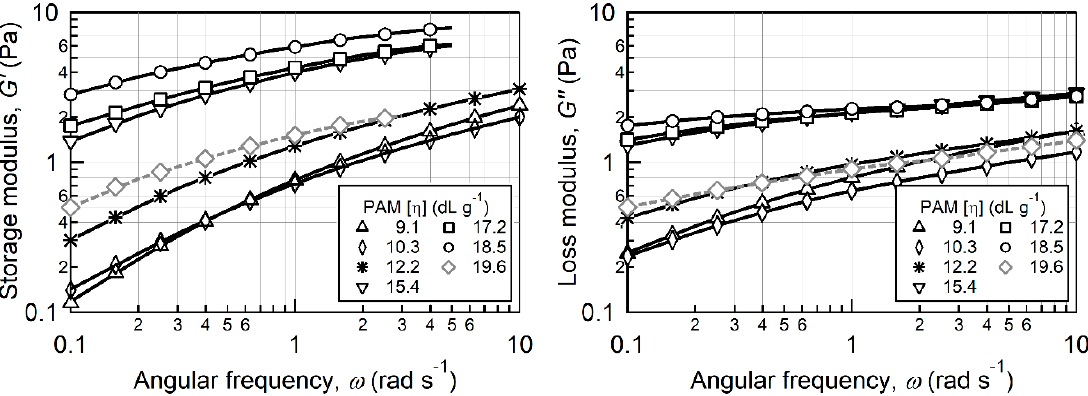
Figure 14. Linear viscoelastic properties of the anionic PAM solutions (adapted from [41]; copyright (2018) with permission from Elsevier).